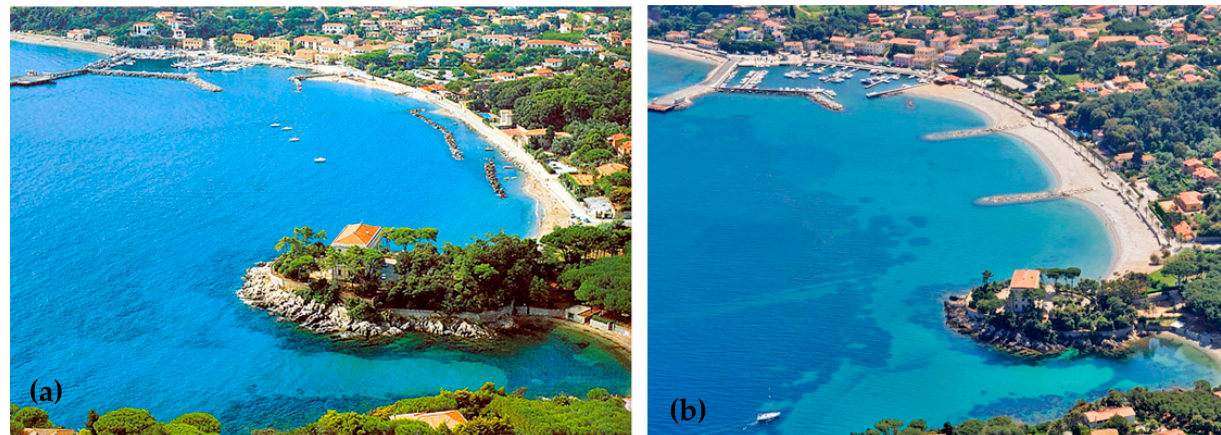
Figure 13. The beach at Cavo before ( a ) and after ( b ) the works (Courtesy www.elbaworld.com).